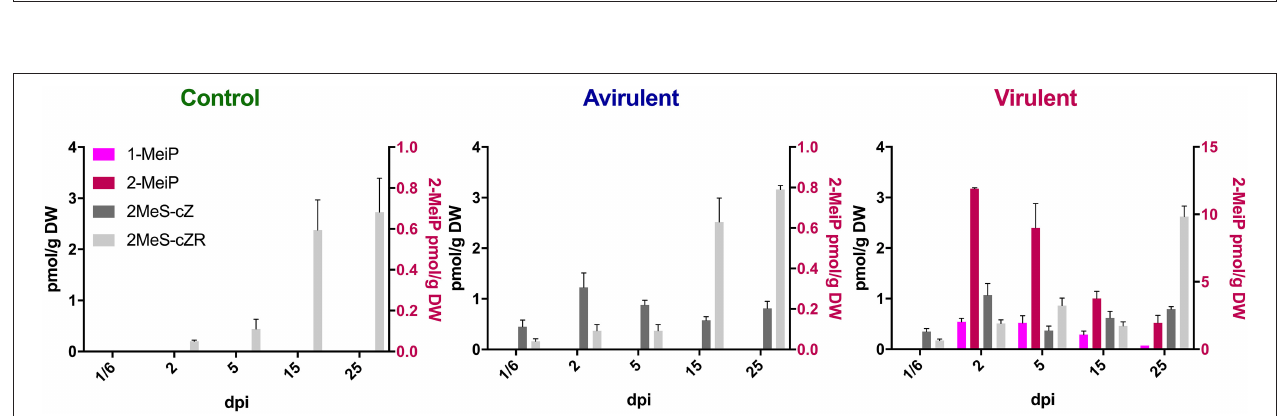
FIGURE 4 | Content of four cytokinins (pmol/g DW) in Pisum sativum cotyledons from 4h post-inoculation ( 1 / 6 days post-inoculation; dpi) to 25 dpi following mock inoculation of pea seeds (Control), or inoculation with R. fascians strains 589 (Avirulent) or 602 (Virulent). The error bars are ± s.d. of four biological replicates.